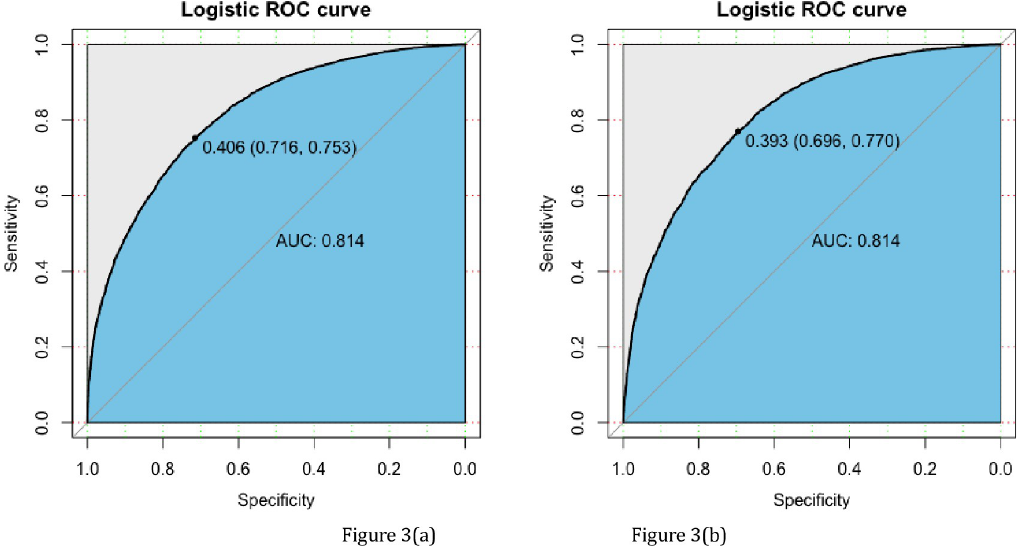
Fig 3. ROC curves for validating the discrimination power of the nomogram. (a) Development group. (b) Validation group. (AUC = 0.814).